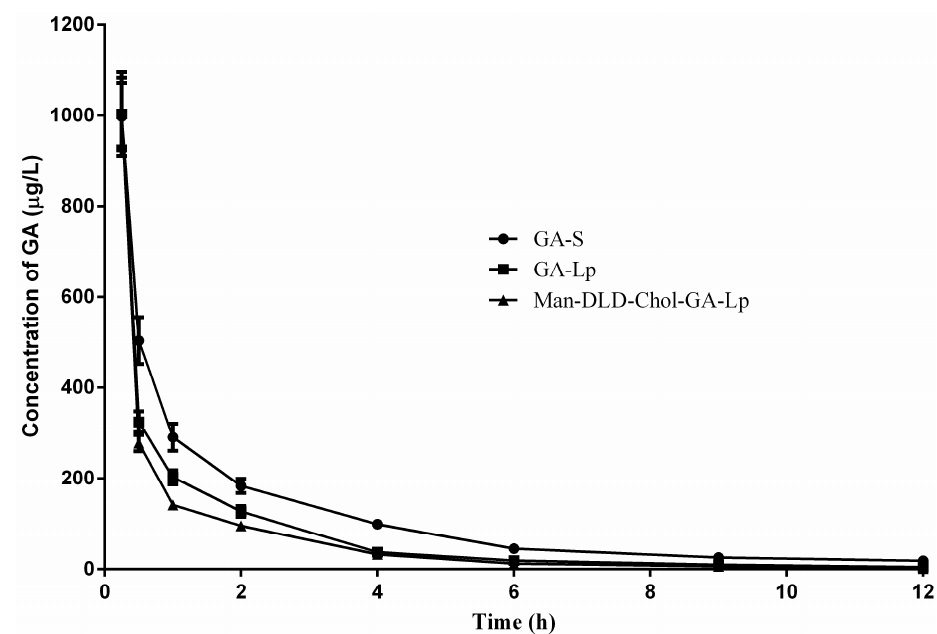
Figure 7. Mean plasma concentration of GA in rabbit after intravenous administration (mean ± SD; n = 6). Table 3. Pharmacokinetics parameters of GA-S, GA-Lp and Man-DLD-Chol-GA-Lp in rabbit plasma (mean ± SD, n = 6).